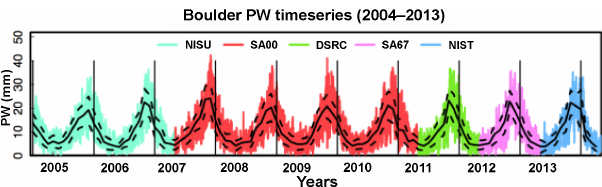
Figure 2. A time series of the GPS PW data for Boulder, Colorado, from 2004 to 2013 with each station denoted by a different color, the monthly means denoted by the solid black line, and ± 1 standard deviation denoted by the horizontal black dashed lines. September of each year is represented by the vertical black